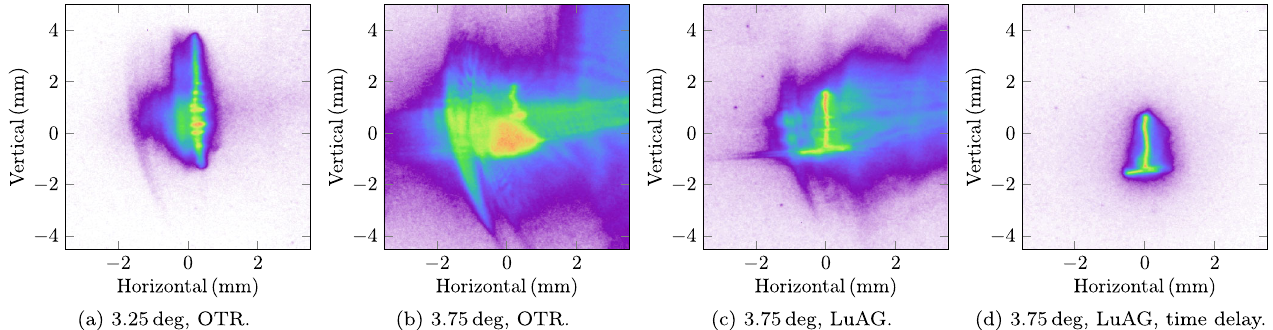
FIG. 10. Single-shot electron beam profile images at K-ICCD for two ACC1 rf phases used in the measurements shown in Fig. 9 with different screen/readout configurations: (a) OTR screen for 3.25 deg, (b) OTR screen for 3.75 deg, and (c) LuAG screen for 3.75 deg without and (d) with delayed readout. The presented single-shot beam profile images are